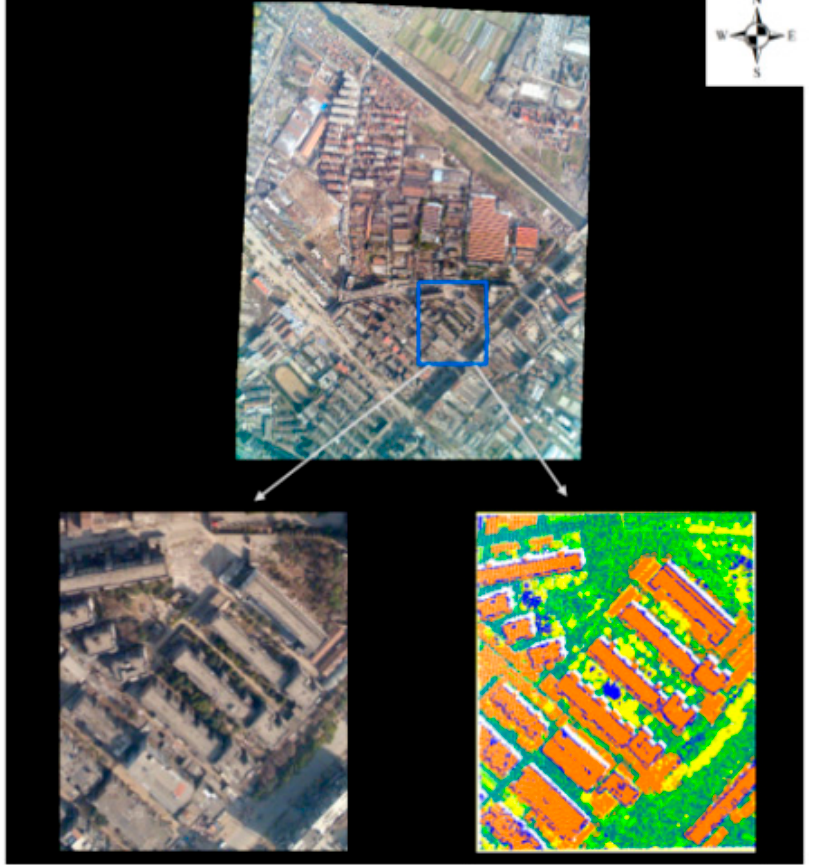
Figure 4. Point-cloud data displayed by elevation in Shashi area and orthophoto image.